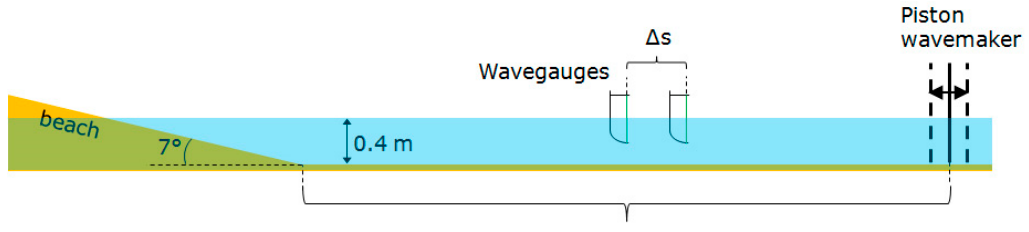
Figure 5. Scheme of the wave flume.